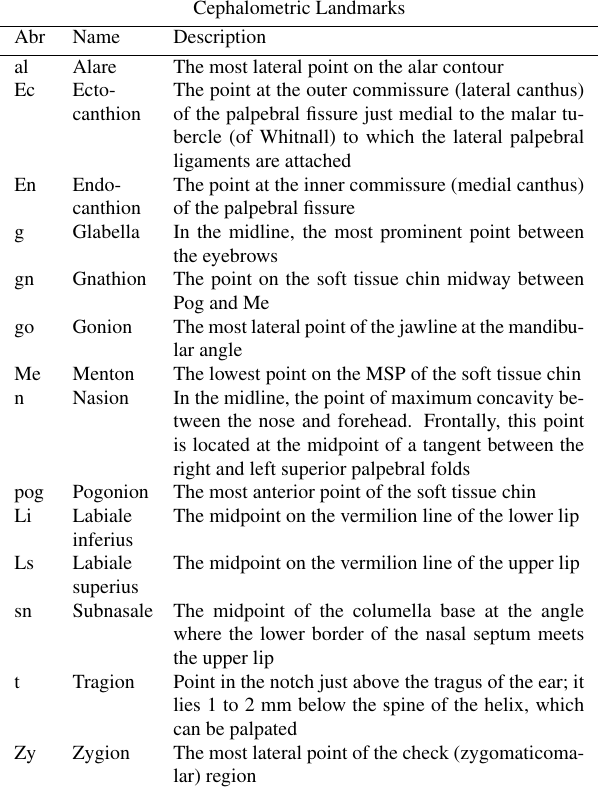
Table 2. Cephalometric Landmarks Usually the landmarks are chosen so that the thickness of the soft tissue is relatively low. The reason for such choice is the neces- sity make decision in case when there can be changes in age and weight of a person.